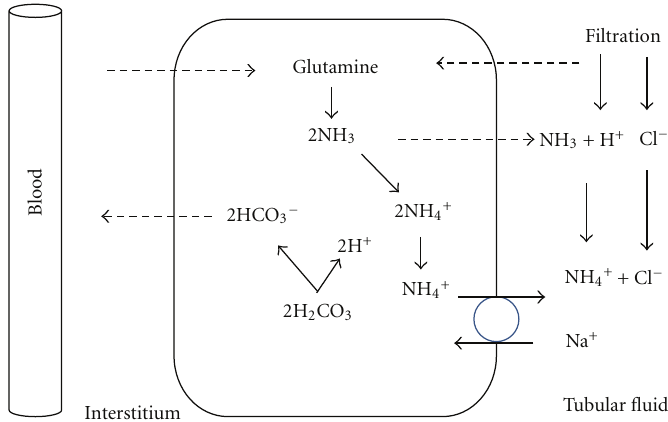
Figure 2: Cellular mechanism for ammoniagenesis and NH 4+ secretion. NH 3 can be secreted into the tubular fluid, where it is then protoned, or it can bind H + within the cell, and be secreted as ammonium ion.